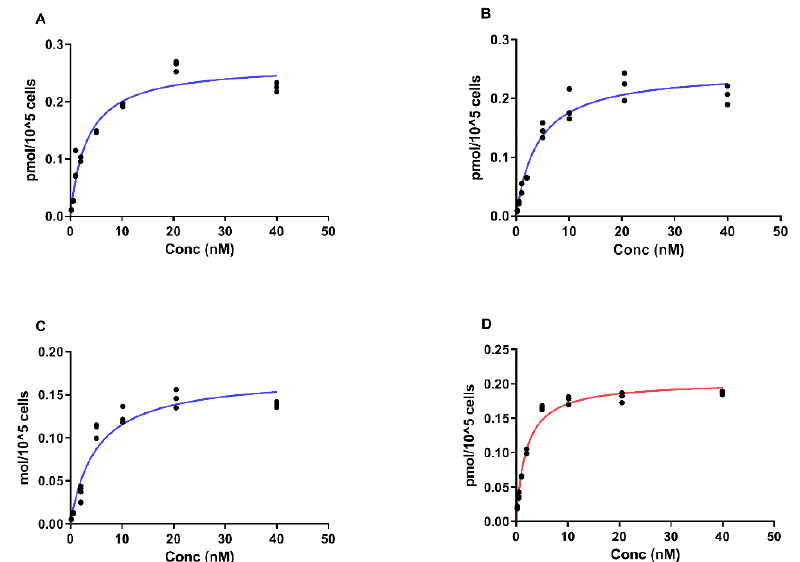
Figure 6. Determination of equilibrium dissociation constants (K D ) of radiolabeled G3 variants by HER2-expressing SKOV-3 cells in vitro. ( A ) [ 99m Tc]Tc-G3-G 3 C, ( B ) [ 99m Tc]Tc-G3-(G 3 S) 3 C, ( C ) [ 99m Tc]Tc-G3-E 3 C, and ( D ) [ 99m Tc]Tc-(HE) 3 -G3. The data are presented as measurements from three samples for each concentration. For some concentrations the points are overlapping. Table 3. Summary of findings from a direct (saturation) receptor ‐ binding curve for the binding of [ 99m Tc]Tc ‐ labeled G3 to SKOV ‐ 3 cells. The K D and B max values derived from the specific binding curves.